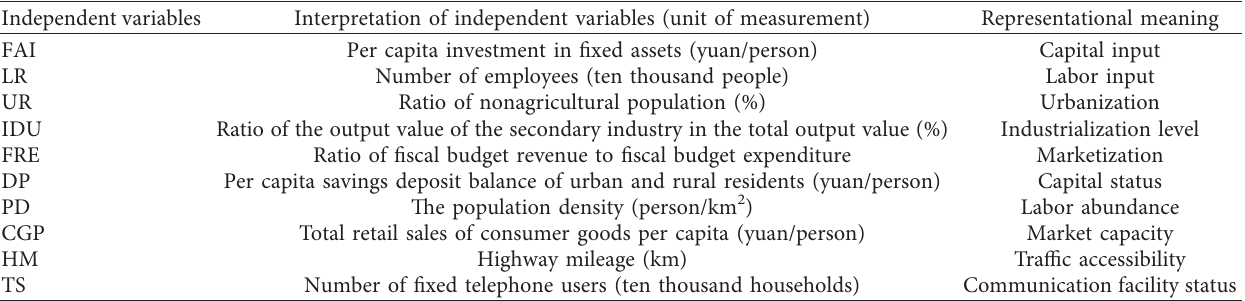
Table 1: Regression variables and representational